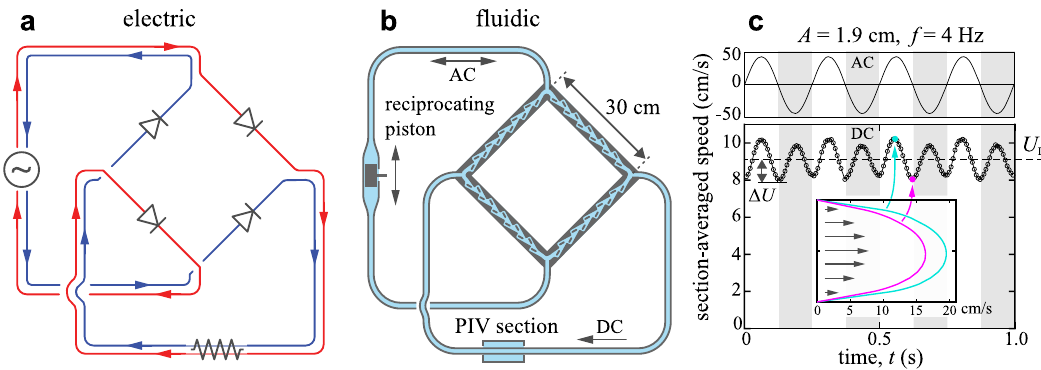
Fig. 5 Electronic AC-to-DC converter and an analogous fl uidic pump. a Electric circuit with four ideal diodes that converts alternating current source (AC, left branch) to direct current (DC, lower branch). Red and blue lines highlight the path and direction of current at different phases in the AC cycle. b Sectional view of an analogous fl uidic circuit with four Tesla diodes and a pulsatile fl ow source. The experimental device employs a reciprocating piston of amplitude A and frequency f as an AC source in one branch, and the DC fl ow is measured in a second branch. c Section-averaged fl ow imposed in the AC branch (top) and measured in the DC branch (bottom) for A = 1.9 cm and f = 4 Hz. The mean fl ow rate U DC > 0 indicates successful AC-DC conversion or pumping. Inset: sample fl ow velocity pro fi les measured by PIV.